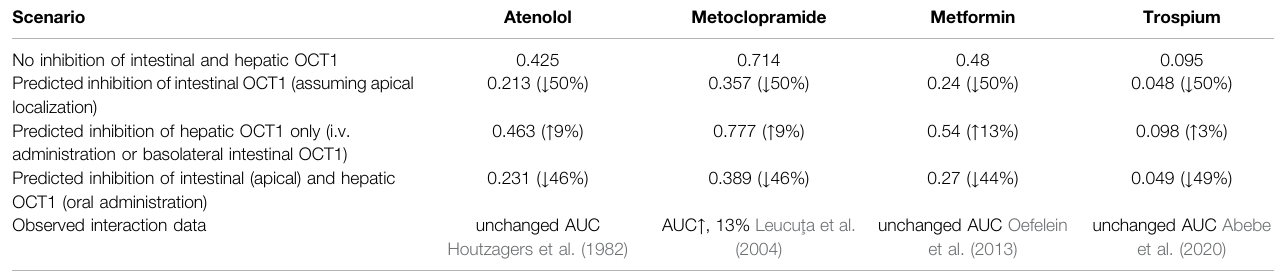
TABLE 5 | Estimated impact on oral bioavailability (F) of OCT1 substrates caused by inhibition of intestinal and/or hepatic OCT1 and observed clinical data.